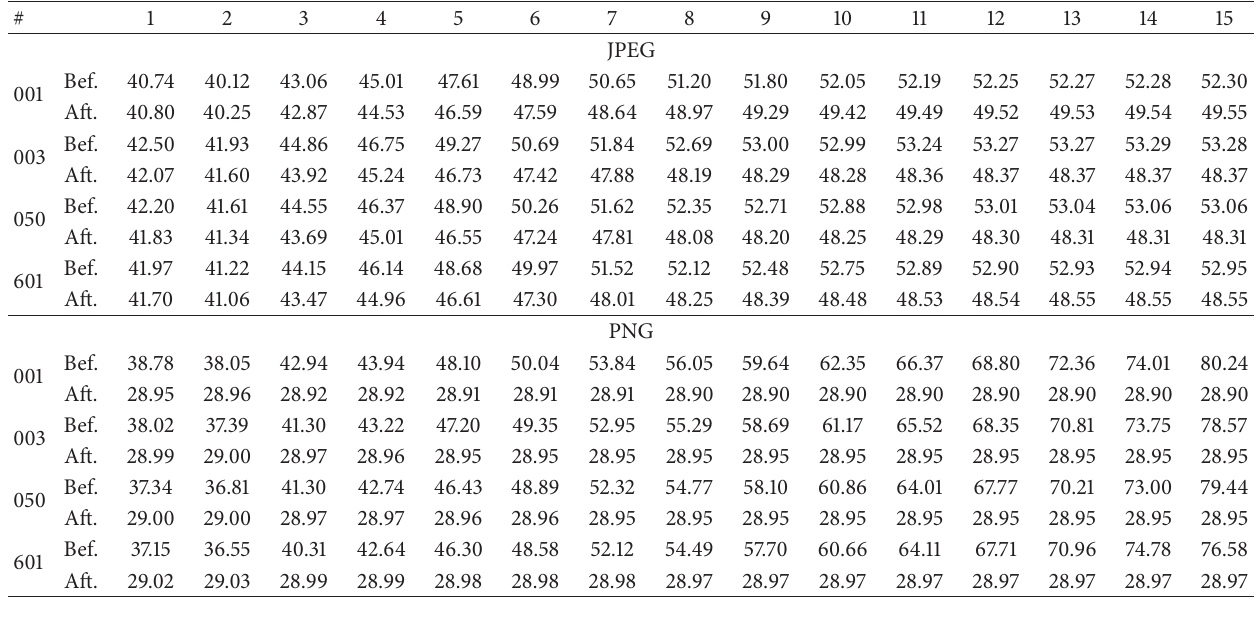
Table 12: PSNR results on Gaussian noise attack.